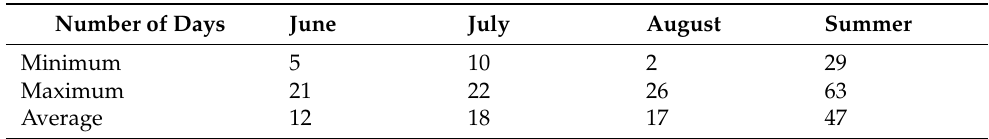
Table 7. Monthly and seasonal values of average, minimum and maximum number of days with strong heat stress (UTCI values above 32 ◦ C) in the period 2000–2021 in ˇCrnomelj. Number of Days June